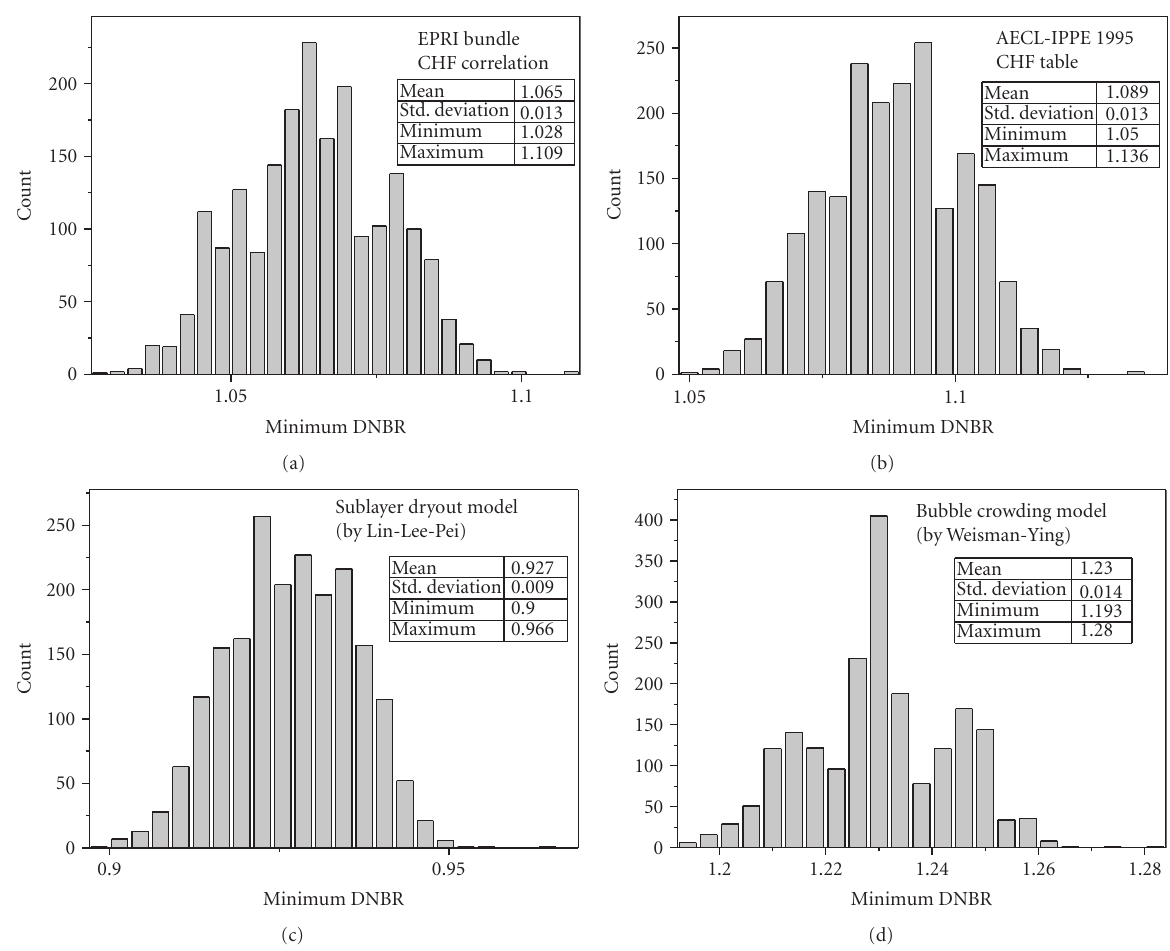
Figure 10: Uncertainty of predicted DNBR for a selected case (test bundle A0, Run